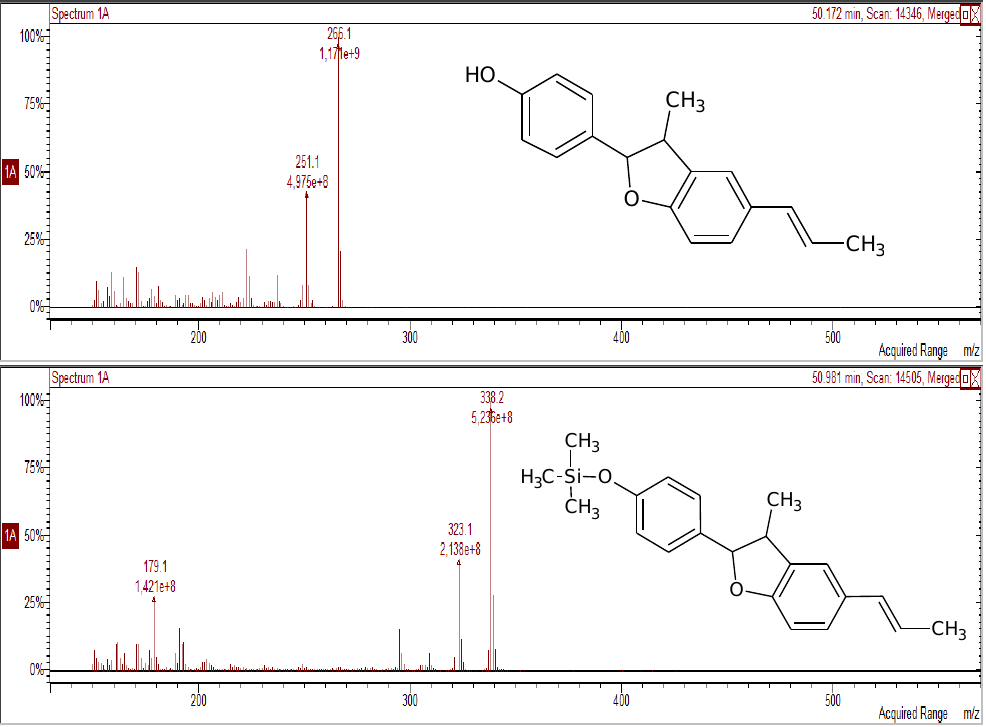
Figure 1. MS analysis of majority peak in 3% fraction 56.61 min, m/z 264 and 57.65 min, m/z 336 (trimethylsililated) corresponding to methylated form of deoxy-kramerixin.